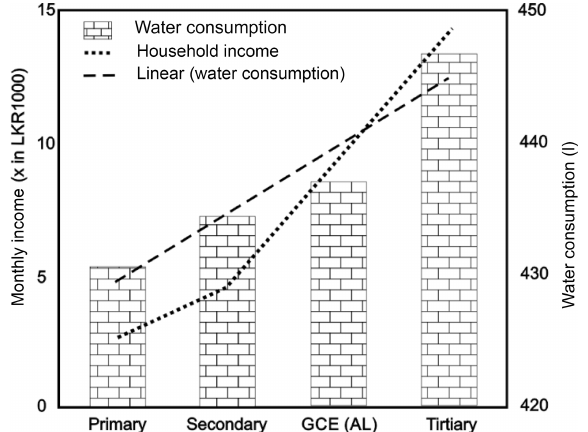
Figure 2. Monthly household income and daily water consumption vs. level of education.